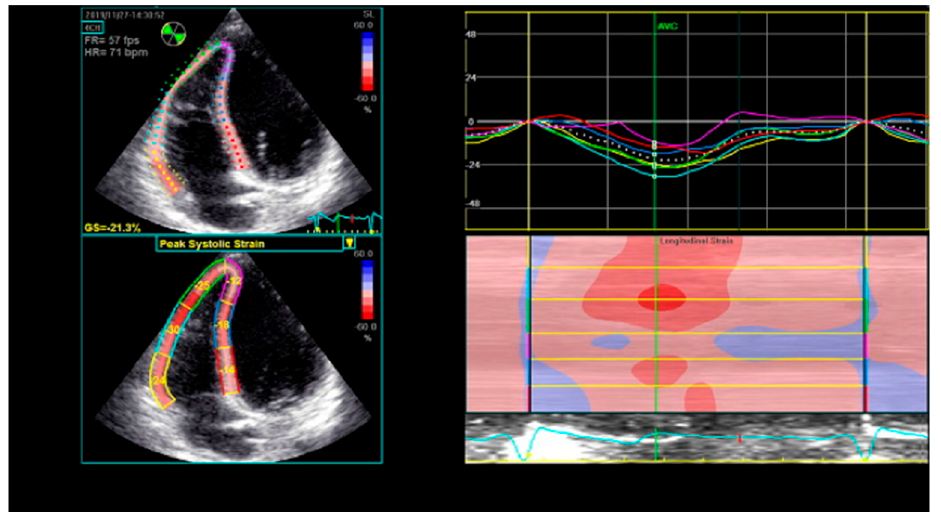
Figure 3. Six-segment model of longitudinal RV strain using STE. RV—right ventricle; STE—speckle-tracking echocardiography.